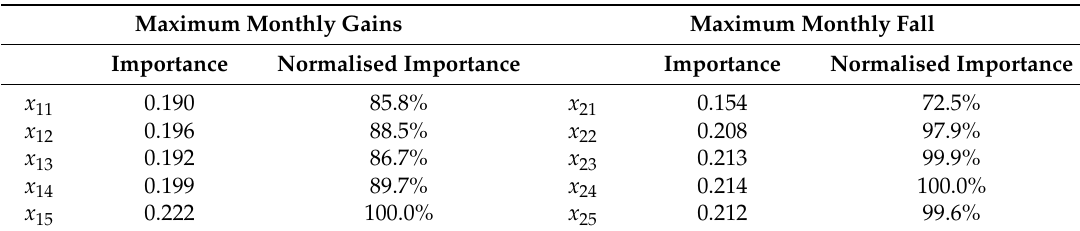
Table 8. Independent variable importance of GSE maximum monthly returns.